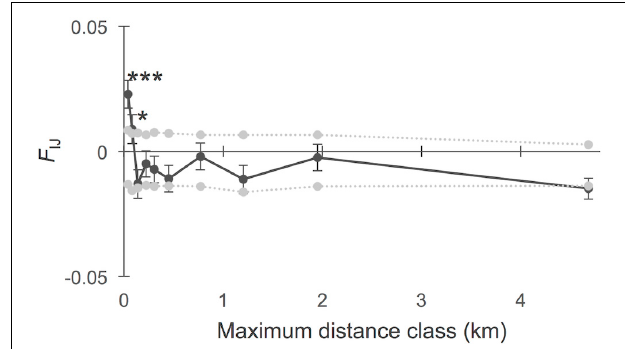
FIGURE 2 | Fine-scale genetic structure of Avicennia marina populations ( N = 14) from mangroves in the Western Indian Ocean region, using even sample size over 10 distance classes. Significant elevated kinship ( F IJ ) values were only within the shortest distance classes of 41 m (*** p < 0.001) and 84 m (* p < 0.05) though not observed beyond hundreds of meters or a few kilometers. The slope of the regression over the full distance was b = –0.009 ( p < 0.01).